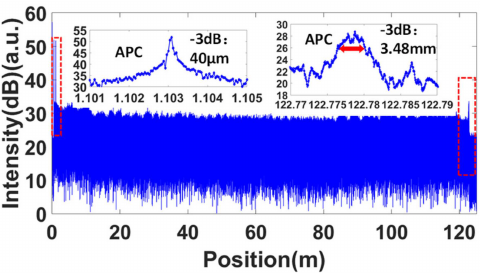
Figure 5. Measured OFDR trace with an APC connector end immersed in a refractive index matching liquid. The first APC connector and the APC at the end of the fiber are shown in the insets. The trace shows a good nonlinearity correction result. The broadened peak of the final APC connector mainly results from the phase noise of the laser and the e ff ect of the refractive index matching